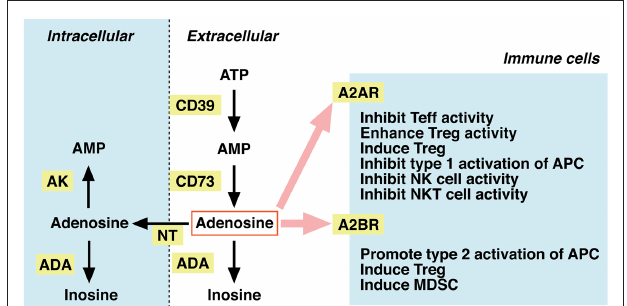
FIgure 2 | Metabolism of extracellular adenosine and its effect on cellular immunity. The activities of CD39 and CD73 produce extracellular adenosine. Extracellular adenosine decreases by adenosine deaminase (ADA)-dependent catabolism and by cellular uptake through nucleoside transporters (NT). Adenosine in the intracellular compartment is converted to AMP by adenosine kinase (AK) or catabolized by ADA. When extracellular levels of adenosine increase, it stimulates A2AR (high-affinity) and A2BR (low-affinity) on immune cells. Adenosine is suppressive to effector T (Teff), NK, and NKT cells. The immunosuppressive activity may be further enhanced by adenosine-mediated induction of Tregs, tolerogenic antigen-presenting cells (APC), and myeloid-derived suppressor cells